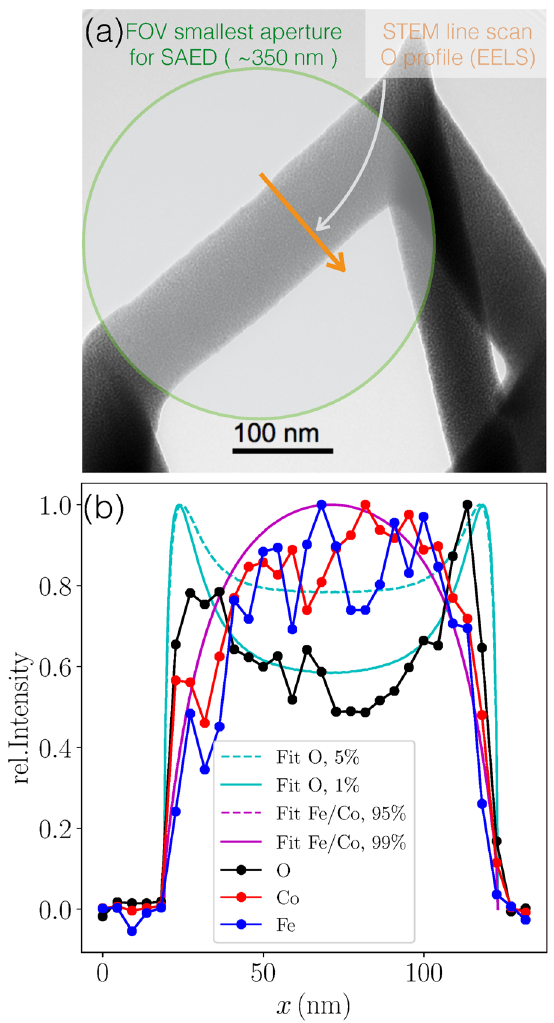
Figure 2. EELS line profiles. ( a ) TEM bright field image of an edge region of one nano-cube. The shaded area in the green circle indicates the region over which the selected area electron diffraction image, shown in Fig. 3 was taken (FOV: field of view). The orange arrow indicates the position and direction of the scanning TEM line along which EELS intensity data at the oxygen, iron and cobalt absorption energy were taken. ( b ) EELS intensity vs. scanning TEM line as indicated in ( a ) (dots and lines). The additional lines (solid and dashed) result from fits of an exponentially decaying (O) or increasing (Fe, Co) concentration from the surface to the center of the nano-cube edge, as detailed in the text. Note that the dashed and solid pink line almost perfectly coincide such that the dashed line is not separately visible. The fit parameters are: R 1 = 50 nm (axis in scan( x ) direction), R 2 = 40 nm (axis in beam( y ) direction), λ = 5.0 nm, f at%. The concentrations given in the legend refer to the assumed O, Fe and Co concentrations in the bulk, i. e. f minO ( ) and f maxFe Co ( / )